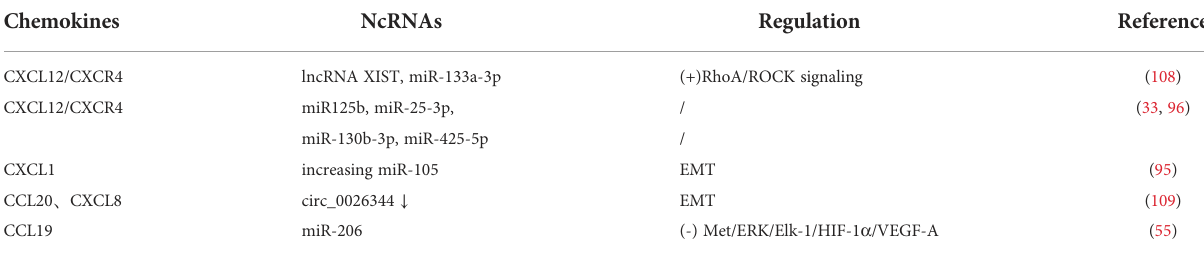
TABLE 2 Chemokines affect the gene regulation of ncRNAs and further embroil itself in tumor progression. Chemokines